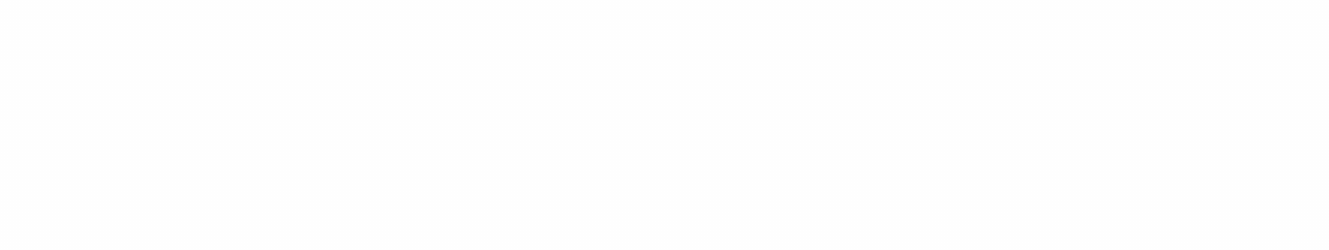
The contracture has been corrected by 2 cm. Achilles tendon lengthening. The passive force has been much reduced, which Fig. 7: is beneficial but also the active force is reduced. When the lengthening has been excessive, this can lead to an inability to